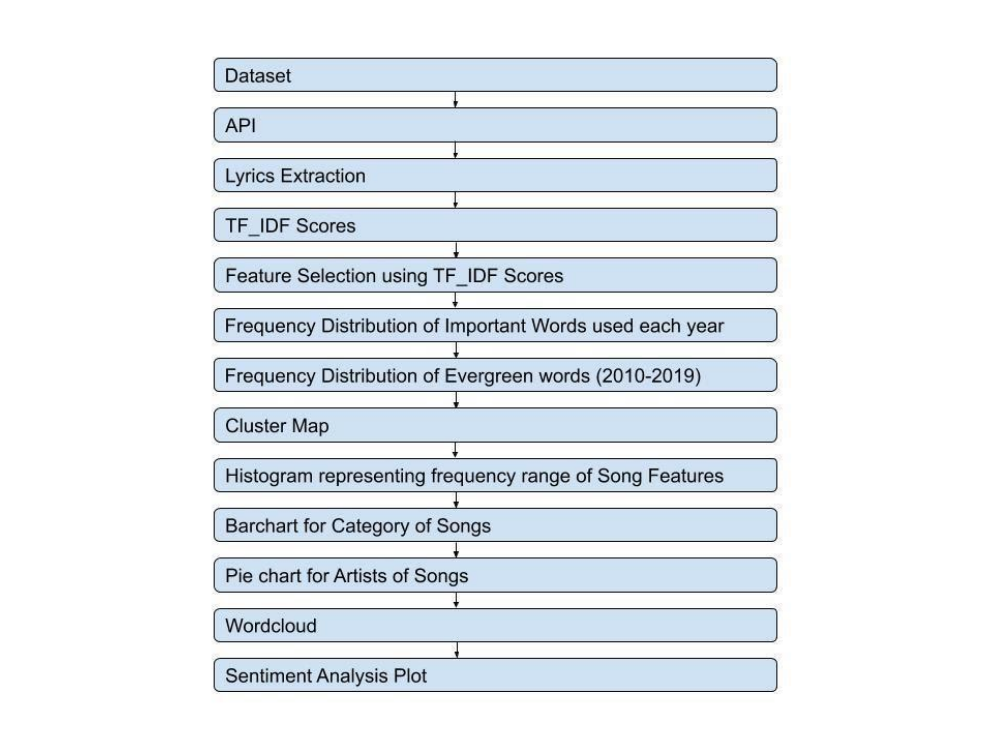
Figure 1. Hot 100 billboard songs dataset analysis flowchart